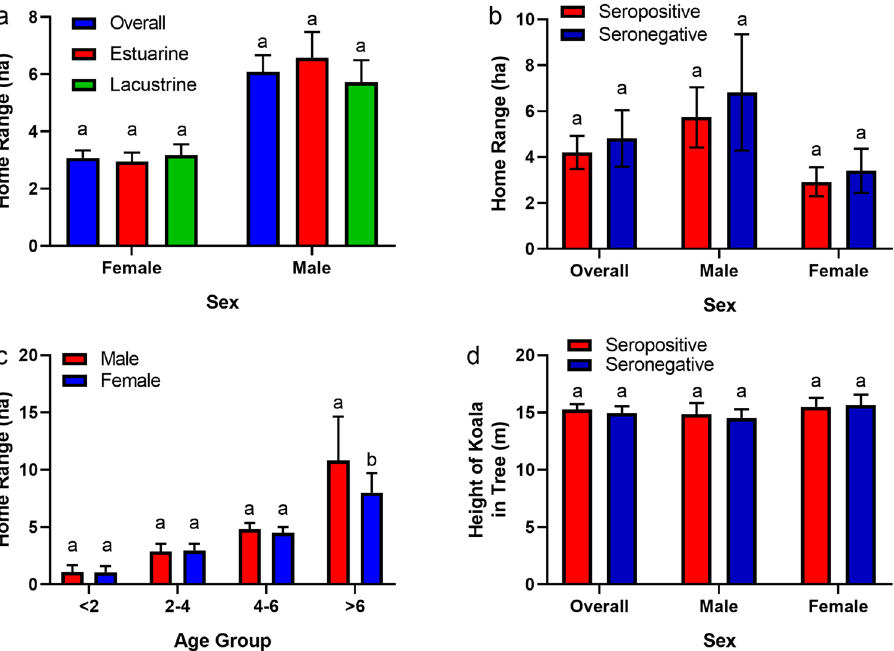
Figure 2. ( a ) Comparison of annual male and female home ranges (mean ± SE), ( b ) comparison of annual home ranges (mean ± SE) of seropositive and seronegative koalas, ( c ) comparison of male and female home ranges by age group (mean ± SE), and ( d ) comparison of koala height (mean ± SE) in trees for seropositive and seronegative koalas. Bars within a graph that do not share similar letters denote statistical